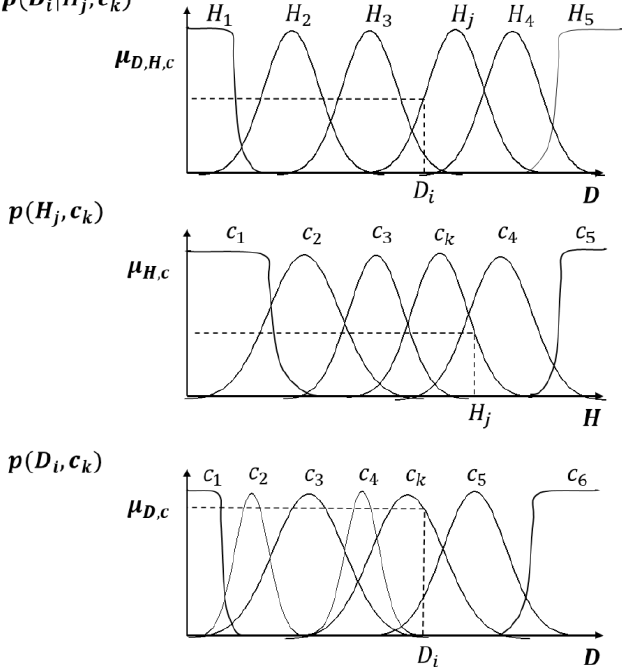
Figure 5. Representations of the information contained in the likelihood (top panel), prior probability (middle panel), and plausibility (bottom panel) in terms of fuzzy sets theory.